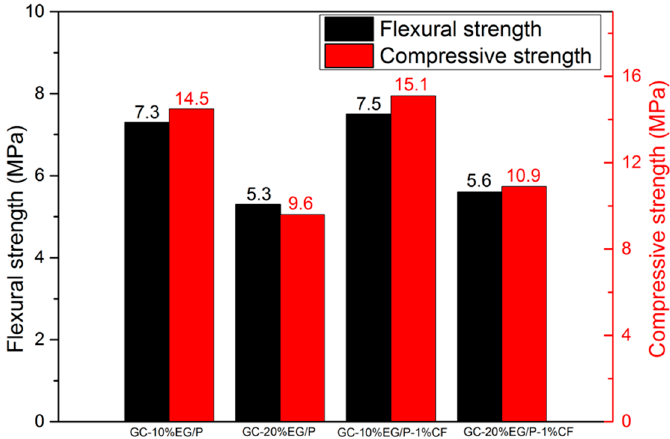
Figure 11. The mechanical strength of EGPG after thermal cycling.